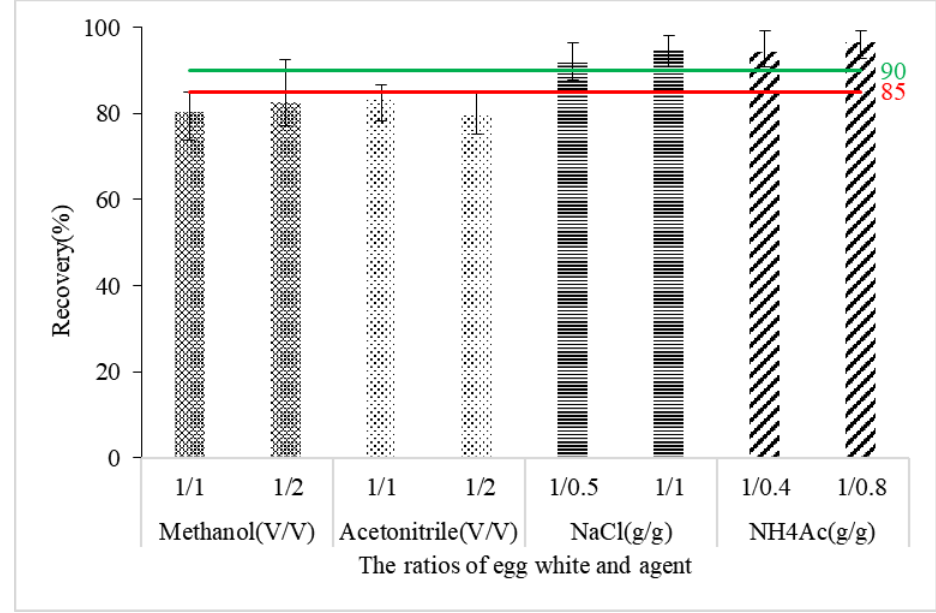
Figure 1. Comparison of different types and proportions of protein precipitants ( n = 5).